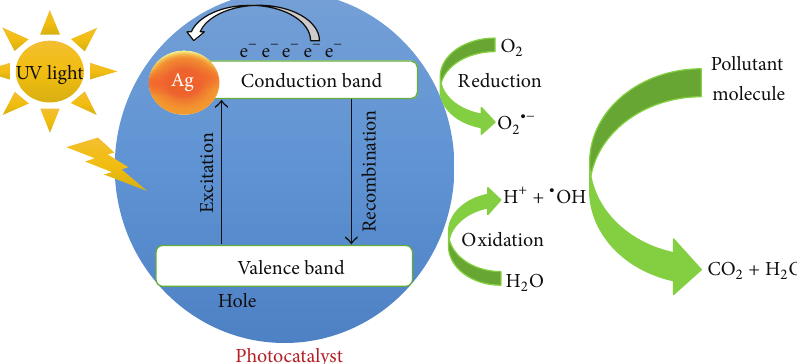
Figure 10: Schematic diagram of the reaction mechanism involved in photocatalytic activity of Ag-MNPs nanoparticles.